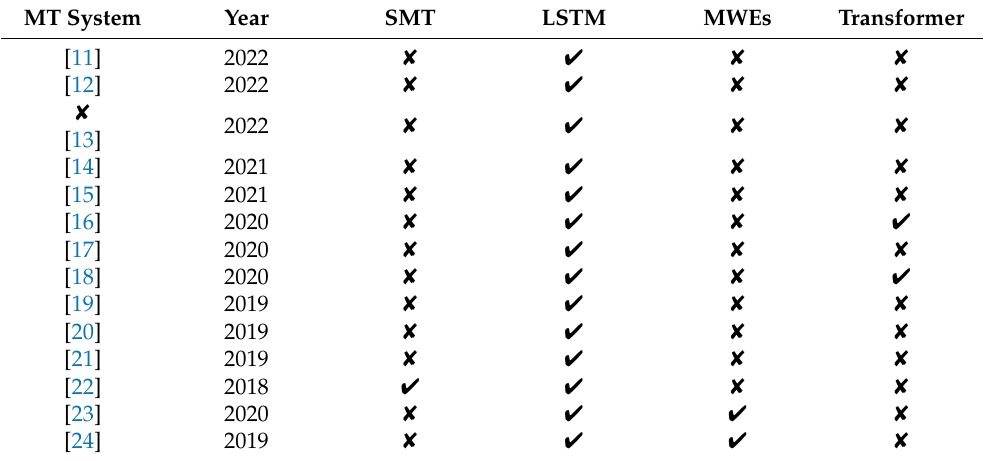
Table 1. Review of different machine translation systems.